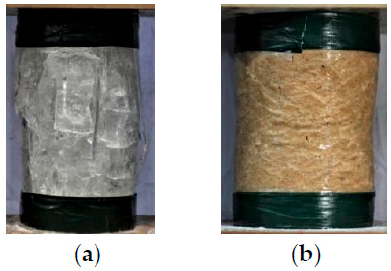
Figure 5. Typical failure modes of ( a ) plain ice specimen and ( b ) sawdust-reinforced ice specimen.